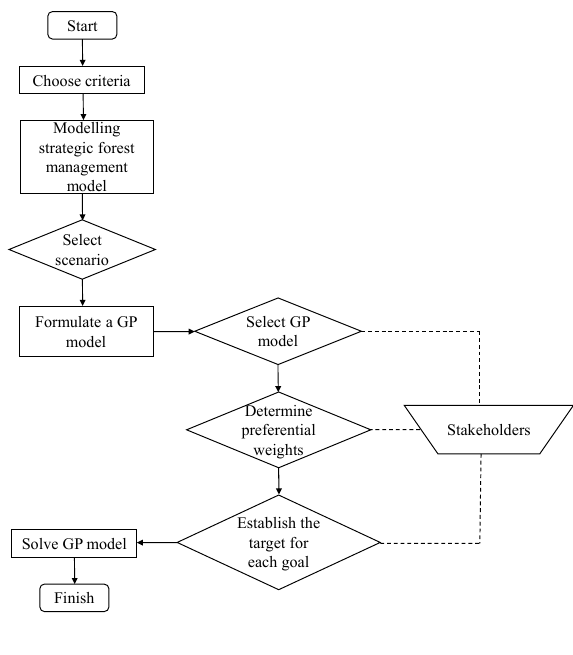
Figure 2. Diagram of the methodologies shown in this